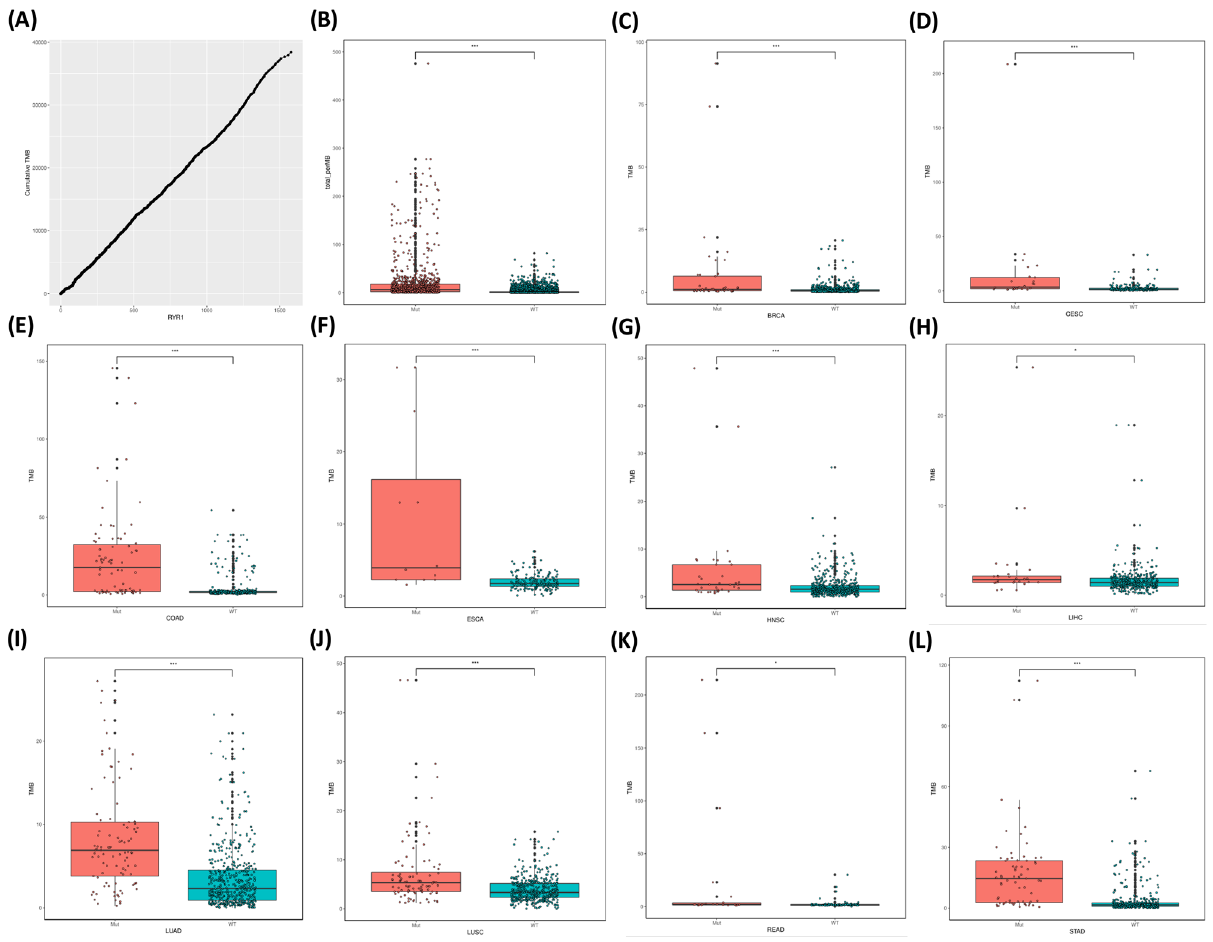
Figure 3. The correlation between RYR1 mutational status and tumor mutational burden (TMB). ( A ) the correlation between cumulative number of mutations (X-axis) and cumulative TMB (Y-axis) in RYR1. ( B ) scatter plot of TMB grouped by RYR1 mutational status (mutant or WT) in all types of cancers. ( C – L ) scatter plot of TMB grouped by RYR1 mutational status (mutant or WT) in each type of cancer, as indicated. *P < 0.05; **P < 0.01; ***P <